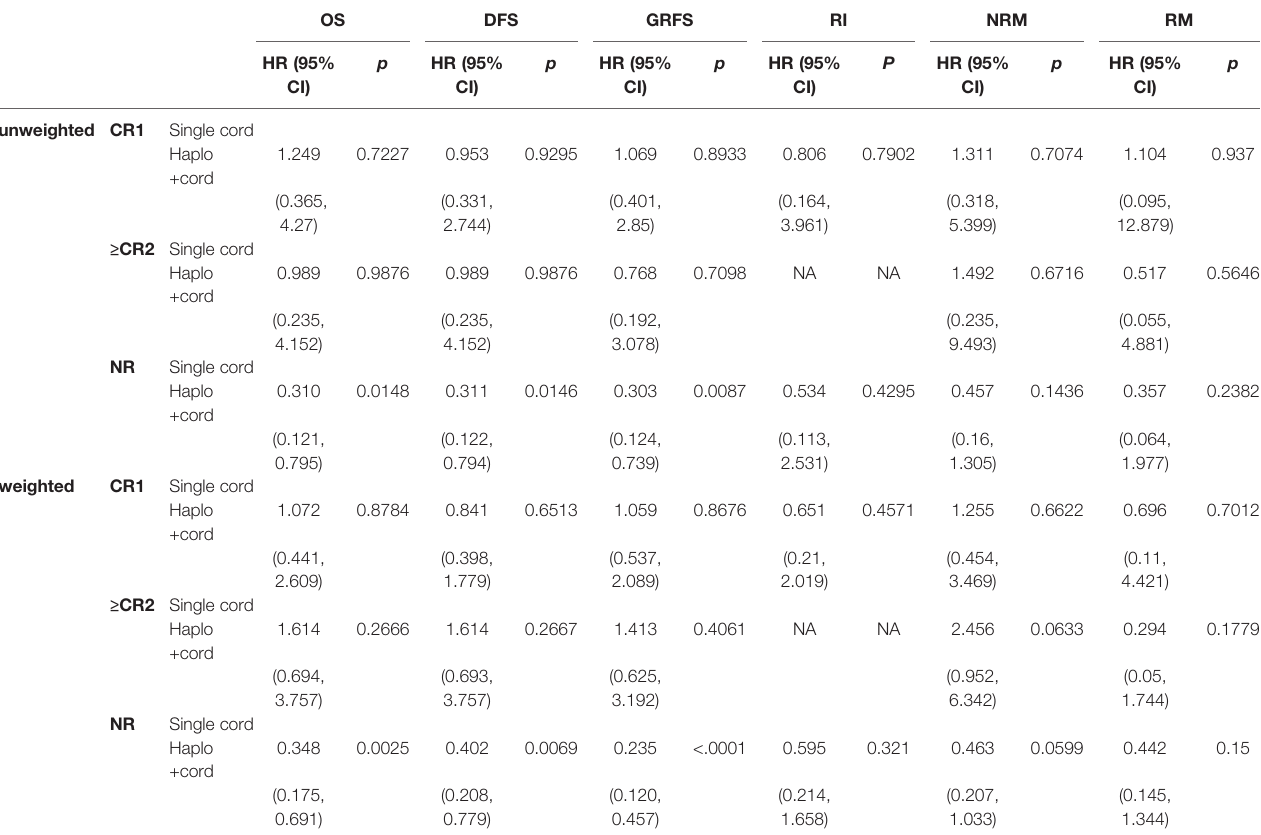
TABLE 3 | Cox regression analysis for different pre-transplant disease status between two groups. OS